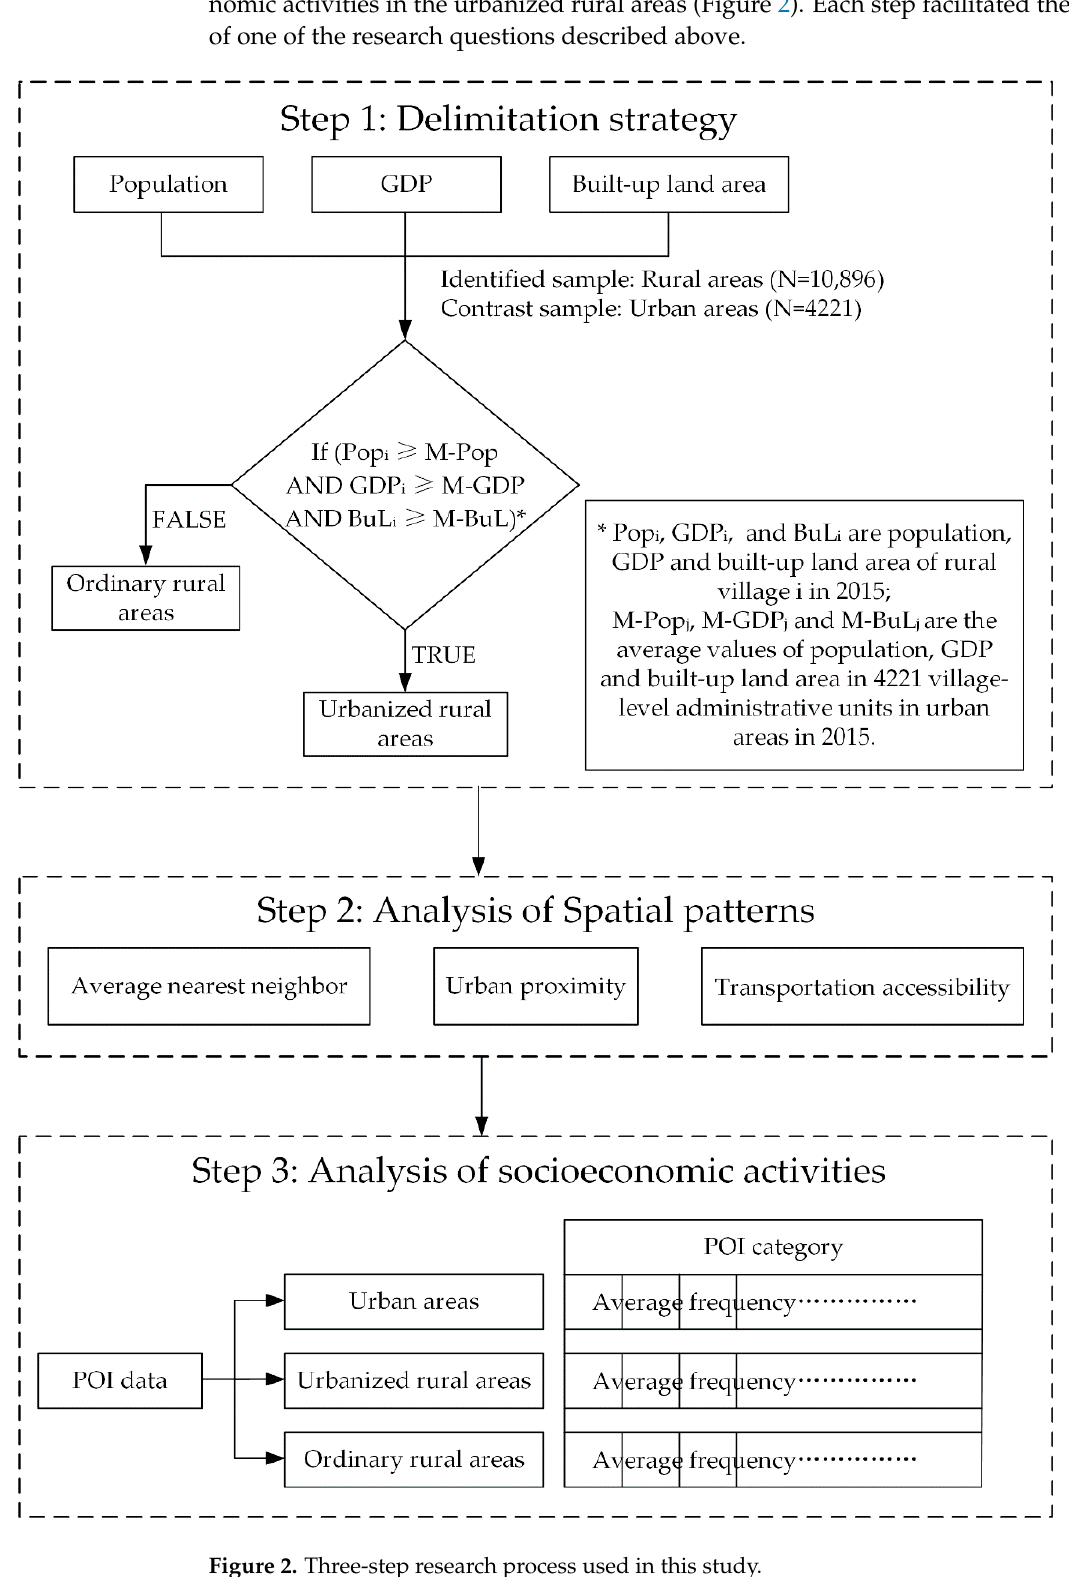
Figure 2. Three-step research process used in this study.